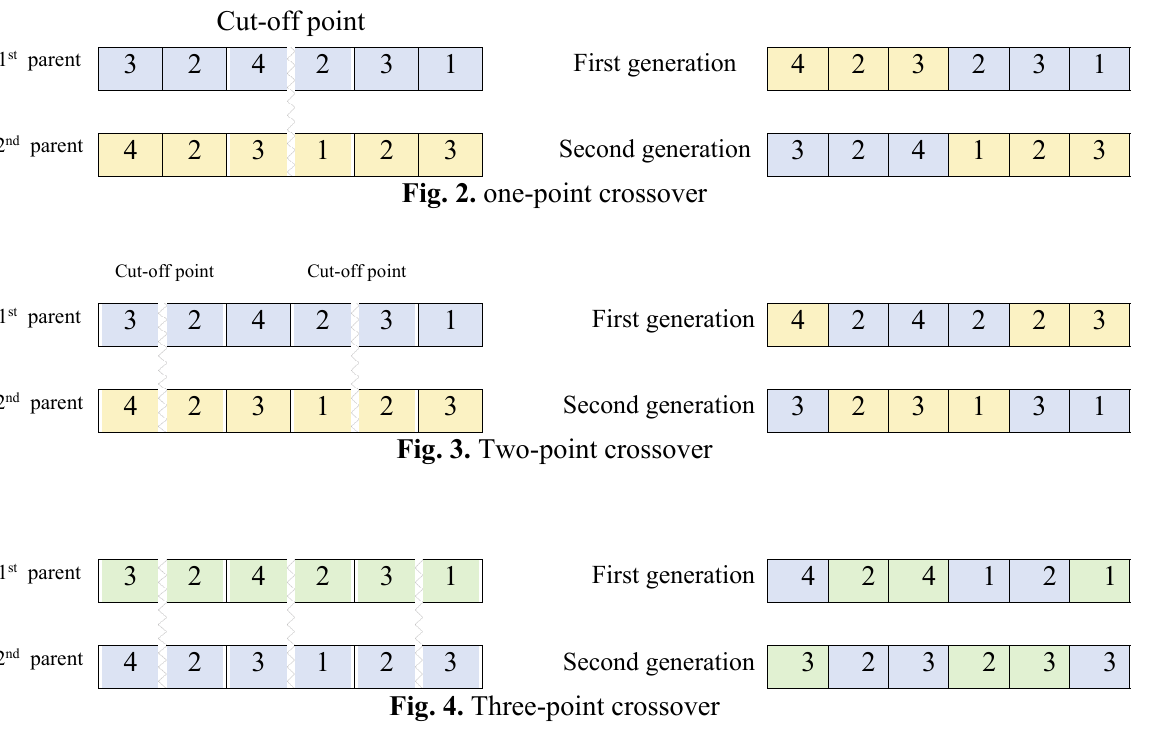
Fig. 2. one-point crossover Cut-off point Cut-off point